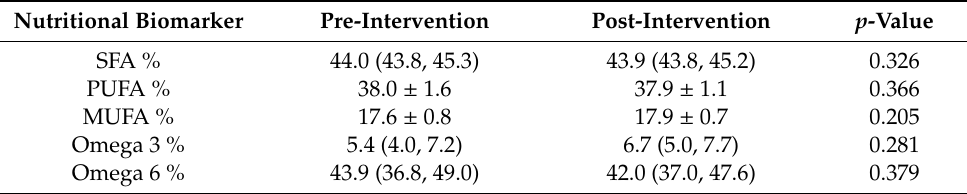
Table 5. Change in red blood cell membrane fatty acids in obese asthmatic children following a 10-week dietary intervention.